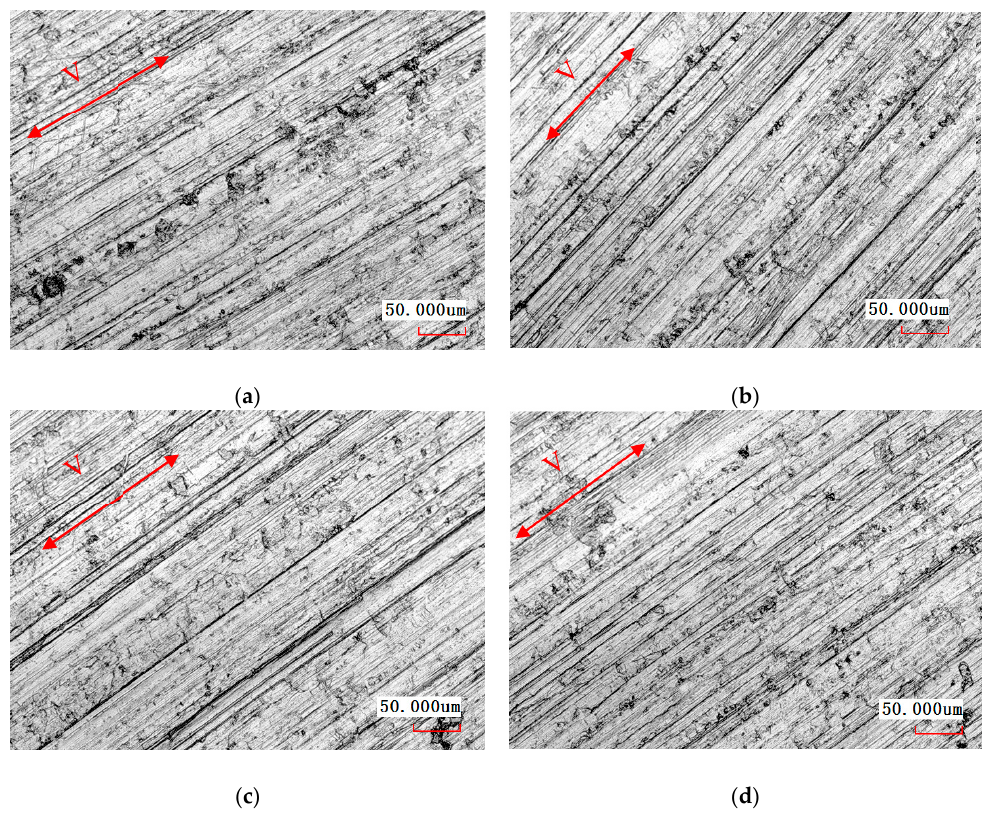
Figure 6. Surface morphology under different sliding speeds. ( a ) 20 mm/s; ( b ) 30 mm/s; ( c ) 50 mm/s; ( d ) 60 mm/s